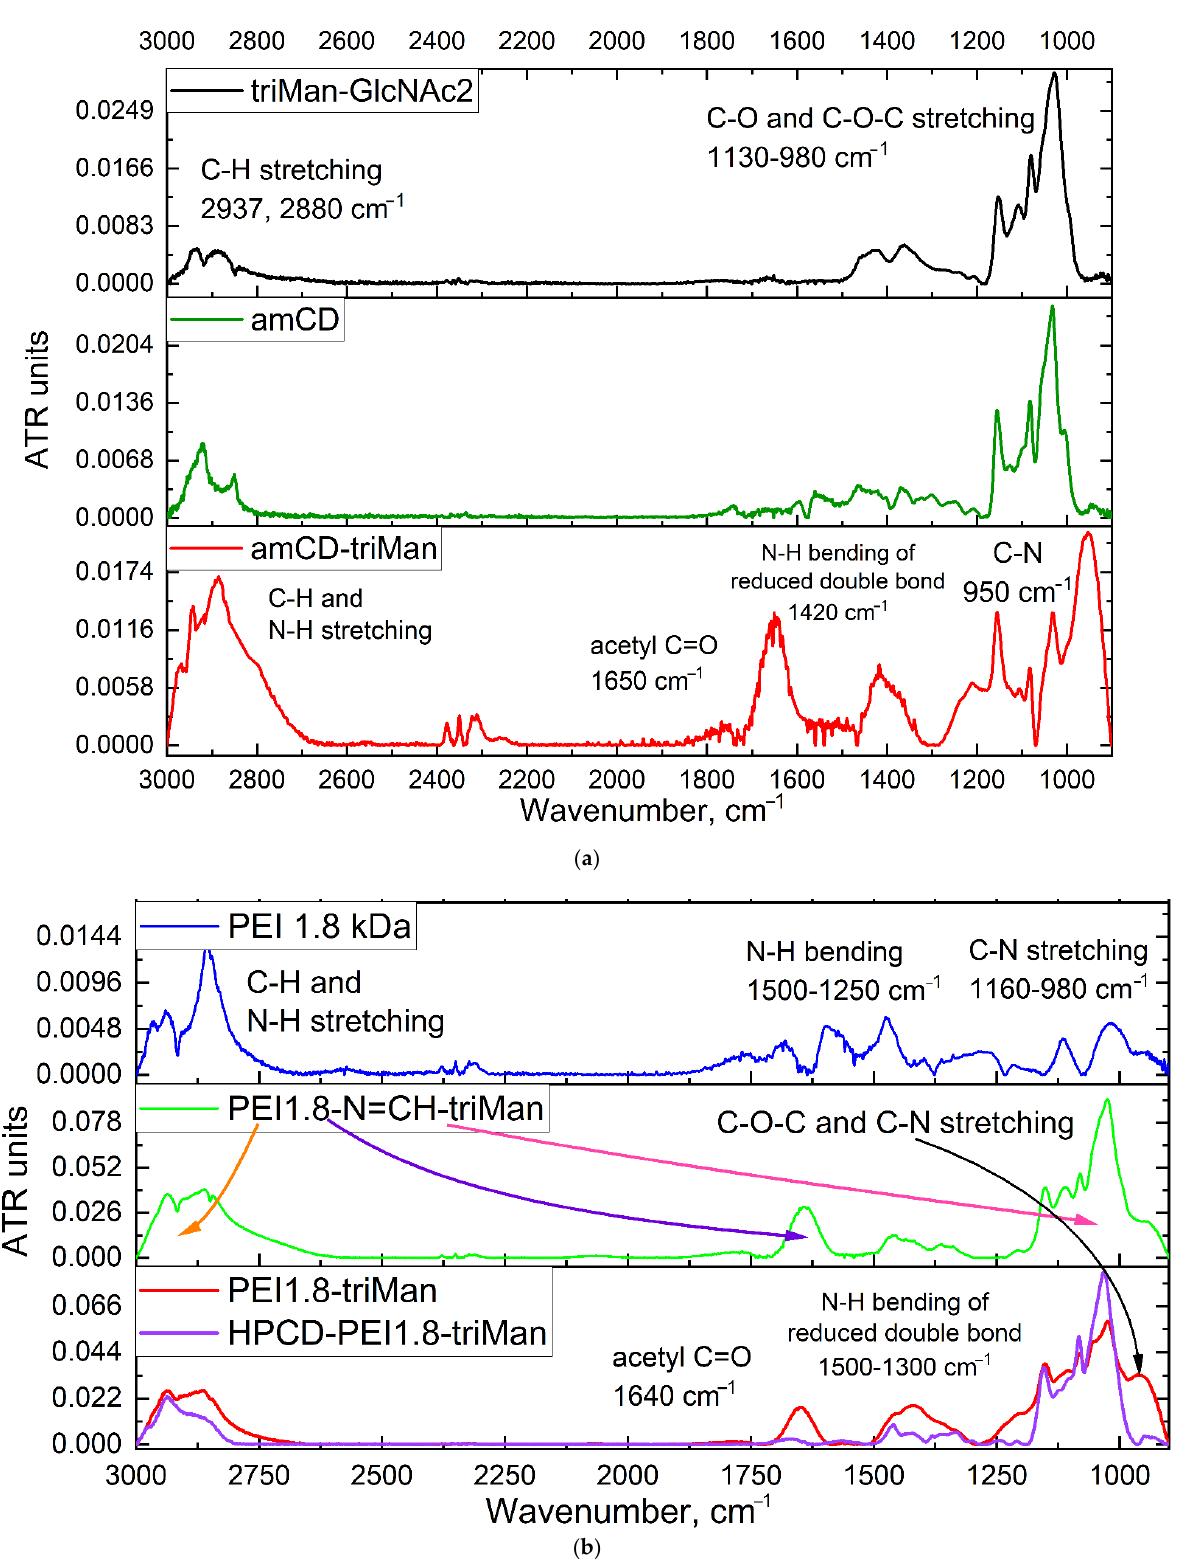
Figure 2. Fourier transform infrared spectra of: ( a ) triMan-GlcNAc 2 , amCD, amCD-triMan; ( b ) triMan- GlcNAc 2 , PEI 1.8 kDa, PEI1.8-N=CH-triMan, PEI1.8-triMan, and HPCD-PEI1.8-triMan. Aqueous solutions. T = 22 ◦